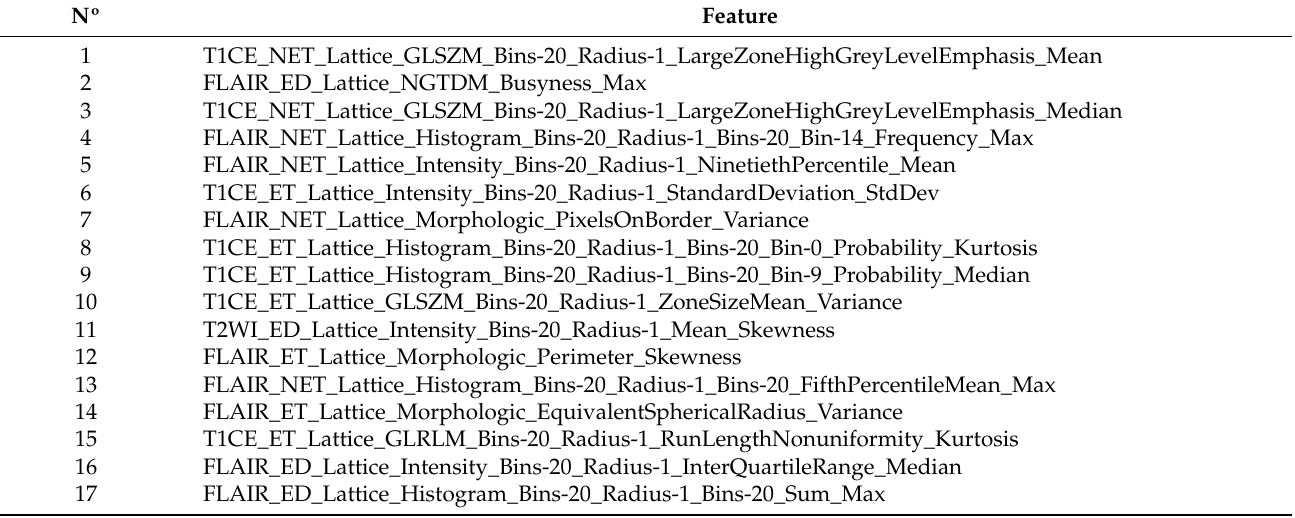
Table 4. Radiomic features selected by the variable hunting algorithm for Random Forest Survival prediction.